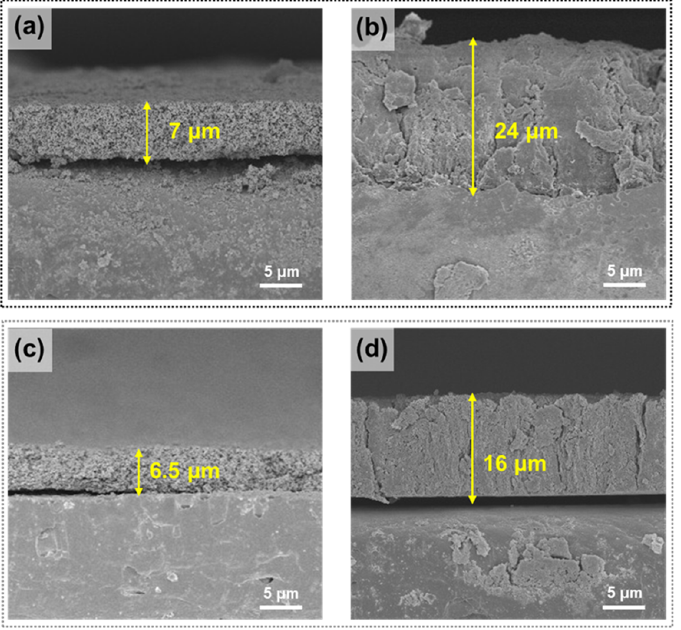
Figure 6. Cross-sectional SEM images: ( a ) Si PAA electrode and ( b ) after 100 cycles; ( c ) Si C-PAA/TAc (5:5) electrode and ( d ) after 100 cycles.